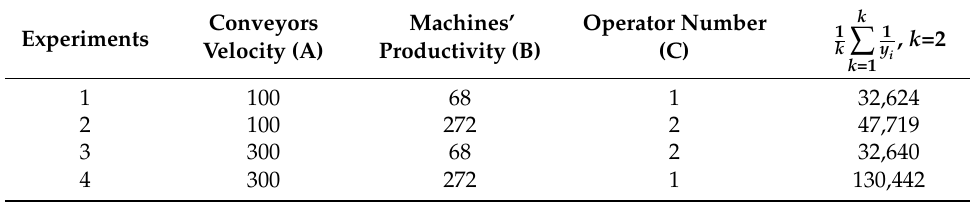
Table 11. L4 Orthogonal Array with Experimental Results.